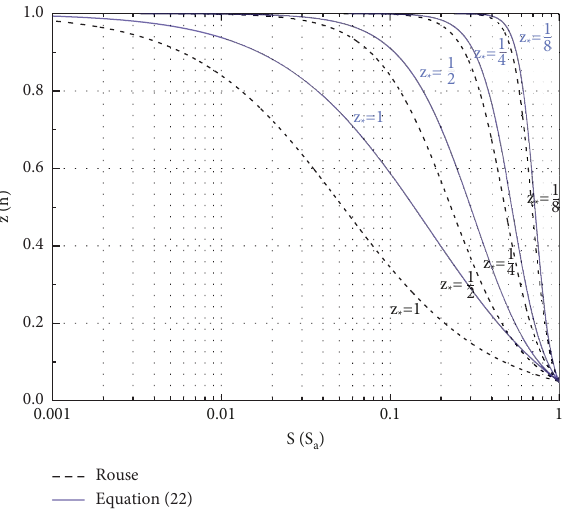
Figure 3: Vertical relative distribution of sediment with diferent m